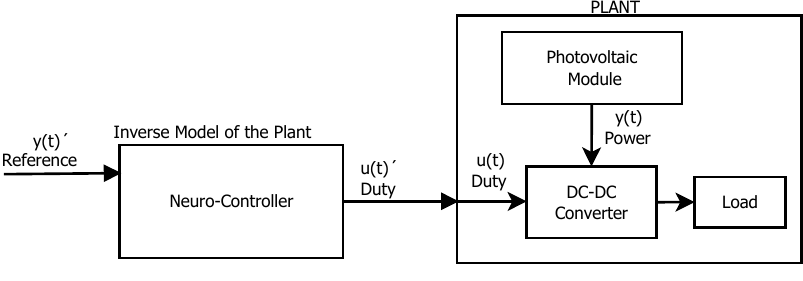
Figure 9. Neurocontroller-plant system.